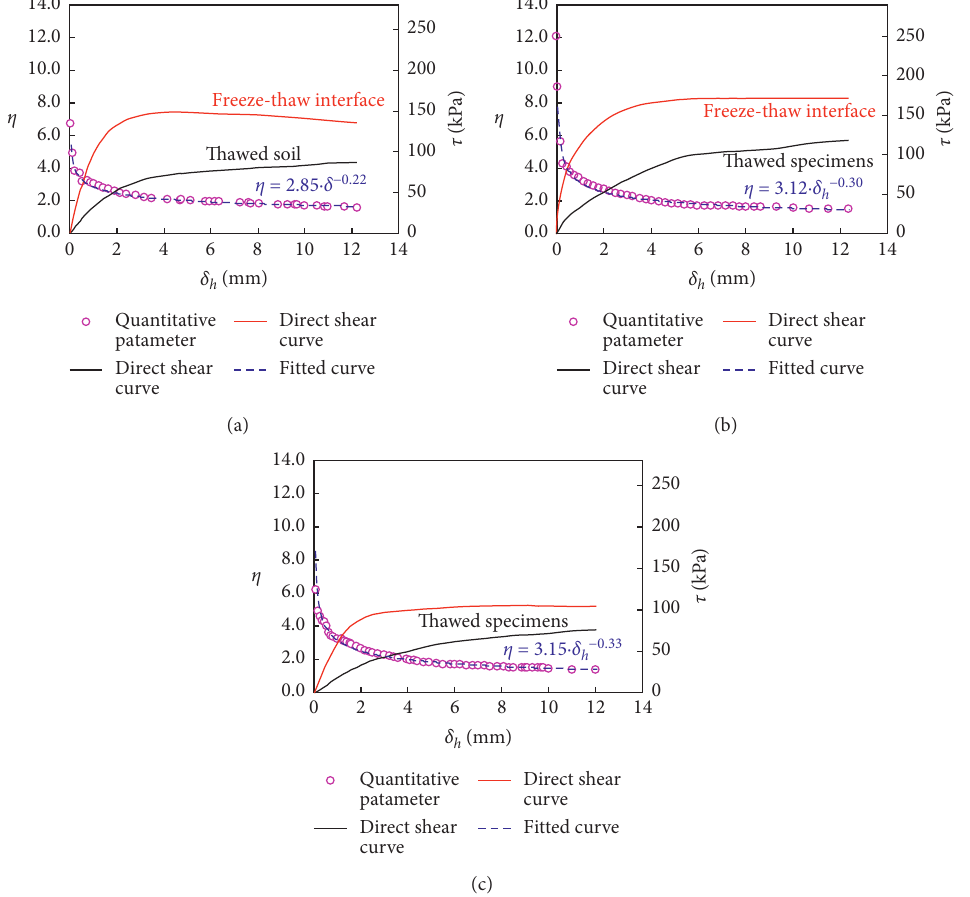
Figure 15: Variation of quantitative parameter ( η ) with shear displacement ( δ